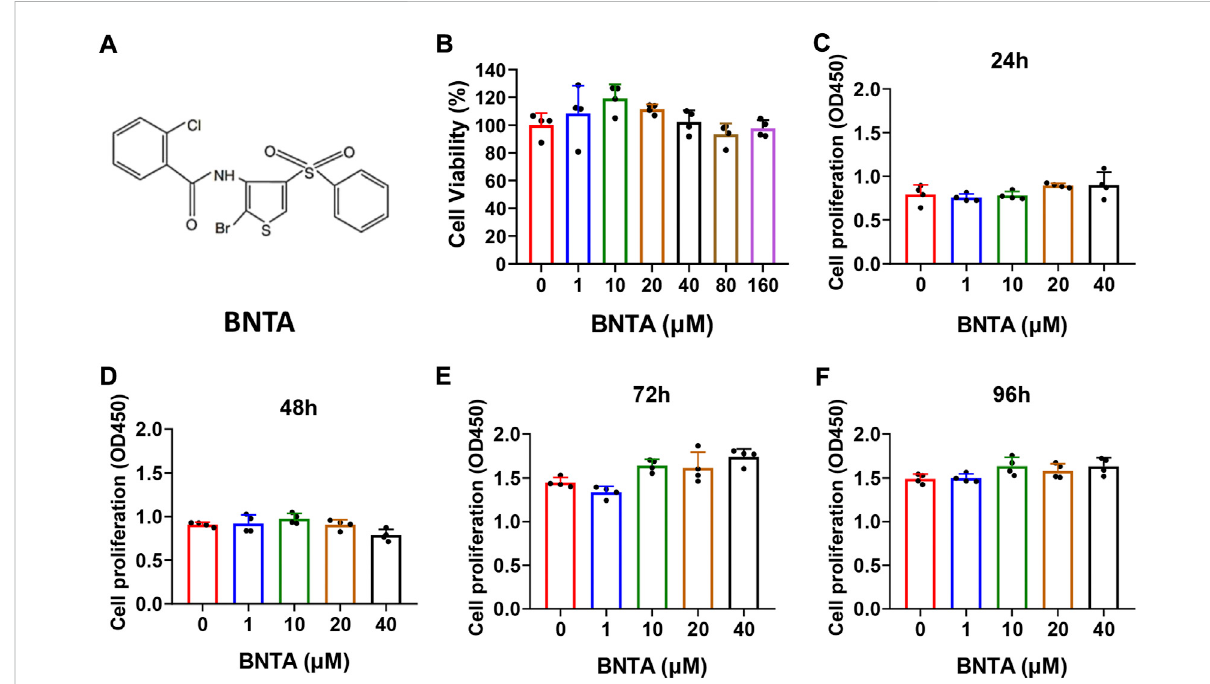
FIGURE 1 Effects of N-[2-bromo-4-(phenylsulfonyl)-3-thienyl]-2-chlorobenzamide (BNTA) on the cytotoxicity and proliferation of bone marrow- derived monocytes (BMMs). (A) The chemical structure ofBNTA. (B) Viability ofBMMs treated by indicated concentrations of BNTA at24 h( n =4 per group). (C – F) The proliferation of BMMs treated by indicated concentrations of BNTA at 24, 48, 72, and 96 h( n = 4per group). All data are presented as mean ±